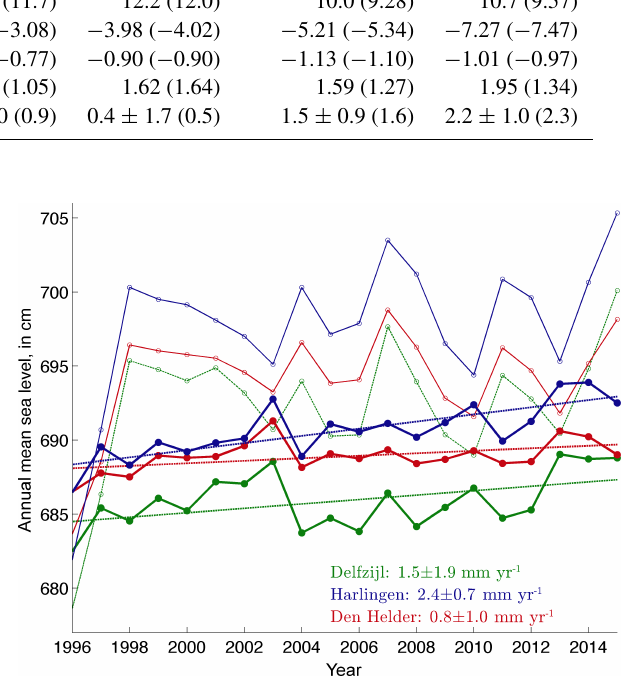
Figure 9. Annual mean sea level at three tide gauges in the Dutch Wadden Sea replicated in thin lines from Fig. 2 for the stations Delfzijl (green), Harlingen (blue), and Den Helder (red). Also shown is the result after correction for atmospheric effects (thick lines), together with fits from linear regression (dashed). The trend with 95% confidence interval on the slope is listed in the legend for each